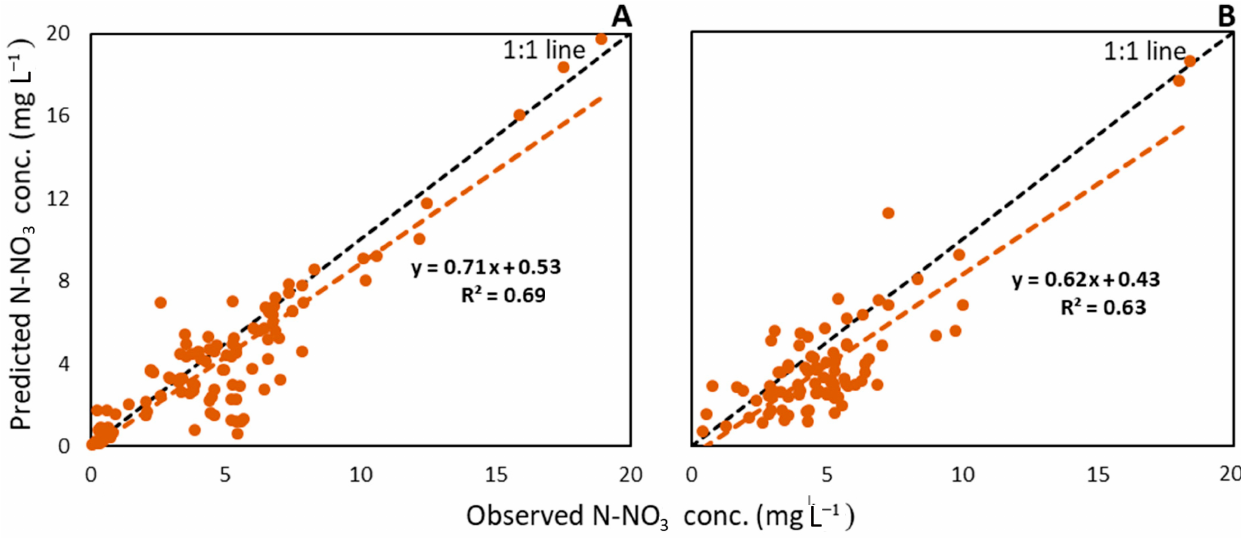
Figure 11. Predicted vs. observed nitrate concentration for the multiple linear regression model. ( A ) Dangishta and ( B ) Robit Bata watershed.